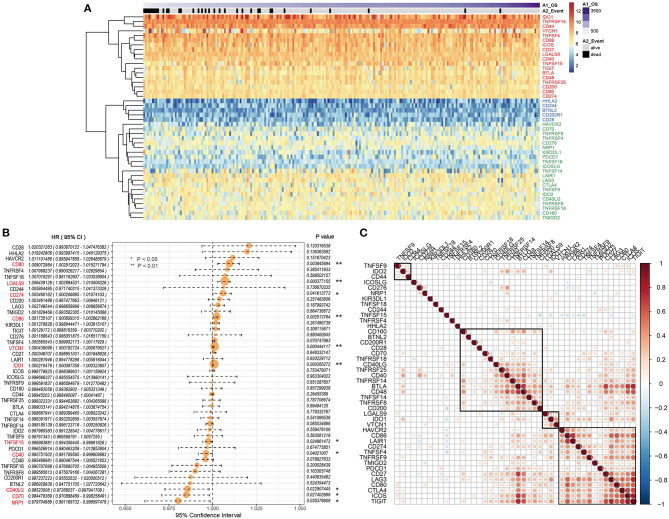
(A) Unsupervised clustering of ICGs in the GSE31210 cohort. The overall survival and status event were used as patient annotations. Red: high expression group; green: medium expression group; blue: low expression group. (B) Relationship between ICGs expression and prognosis in forest plot. Abscissa represents 95% confidence interval, ordinate (left) represents gene, and the vertical line in the middle of P-value represents the invalid line. When the horizontal line of 95% confidence interval of a gene crosses with the invalid line, it can be considered that there is no statistical correlation between gene expression and patient survival. If the horizontal line falls to the left of the invalid line, the gene can indicate a higher likelihood of success for patient prognosis. If the horizontal line falls to the right of the invalid line, it can be considered as a risk factor for the patient survival. (C) Correlation heatmap of ICGs expression levels. Only the gene pairs with significant correlation test are shown: the blank indicates zero significance of correlation test, blue represents negative correlation, and red represents positive correlation. *P < 0.05, **P < 0.01.